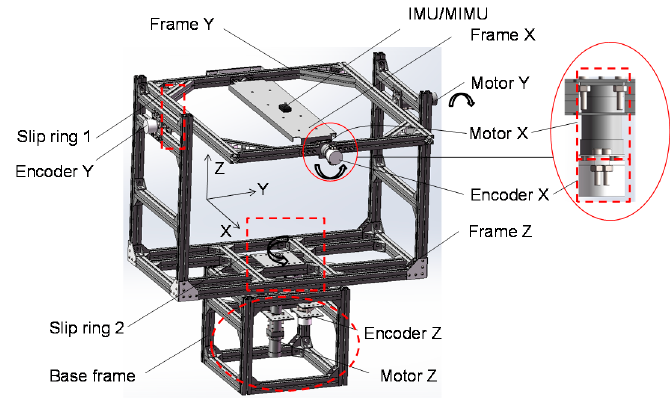
Figure 4. The model of three-axis instrumented gimbal.